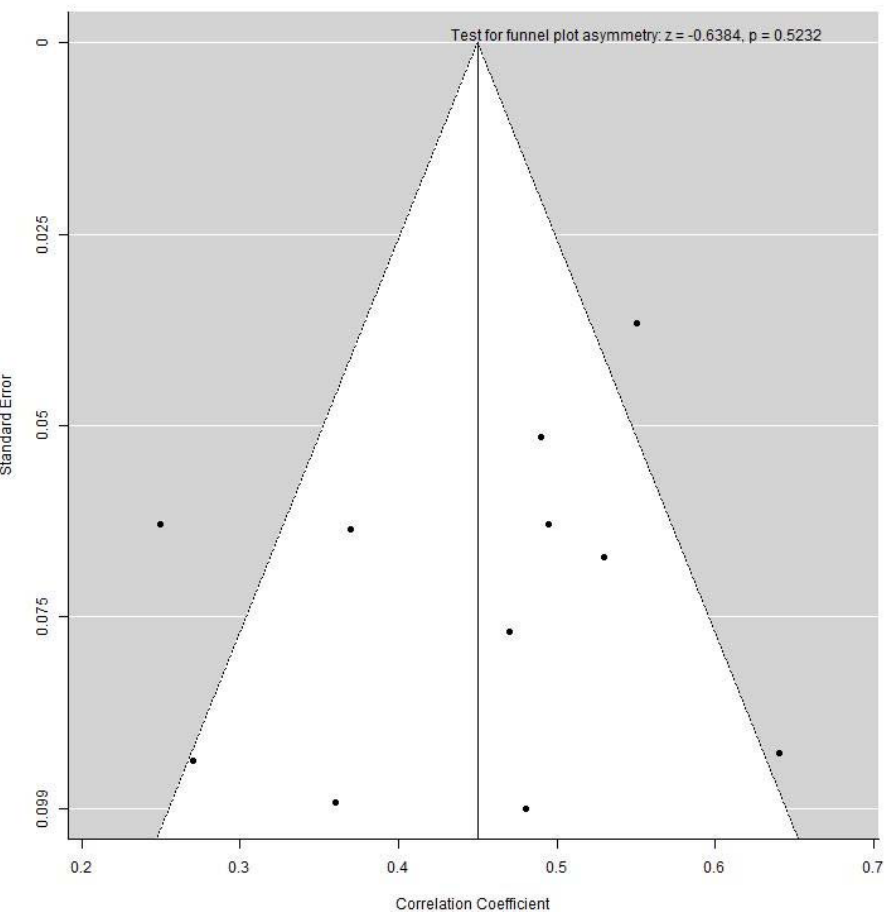
Figure 4. Funnel plot examining heterogeneity in the cord blood leptin and fat mass at birth group.